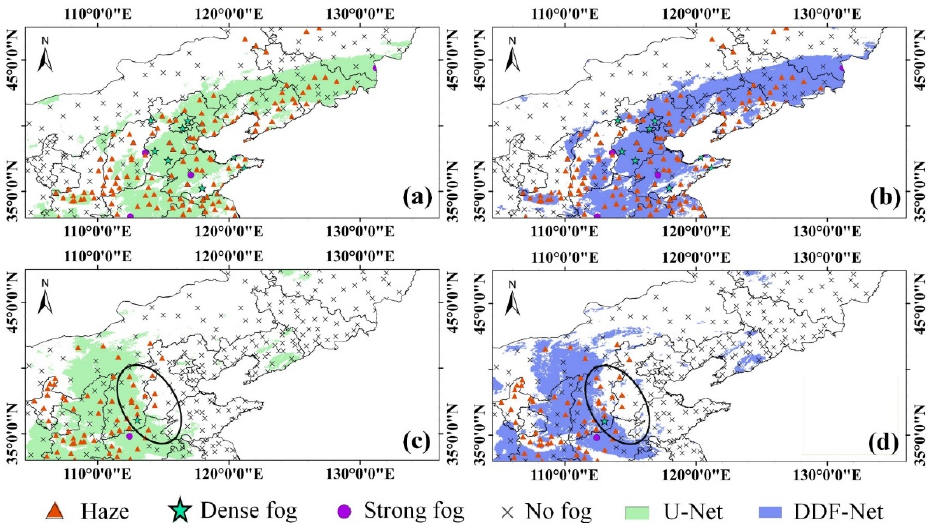
Figure 9. The fog detection results of U-Net and DDF-Net at 17:00 (18 November 2016 ( a , b ) and 11 December 2016 ( c , d )). The triangle, star, circle, and cross symbols represent haze, dense fog, strong fog, and non-fog stations, respectively. The green area is the fog detected by U-Net. The blue area is the fog detected by DDF-Net. All the times are at the Beijing Time (8 h later than the Universal Time Coordinated (UTC)).